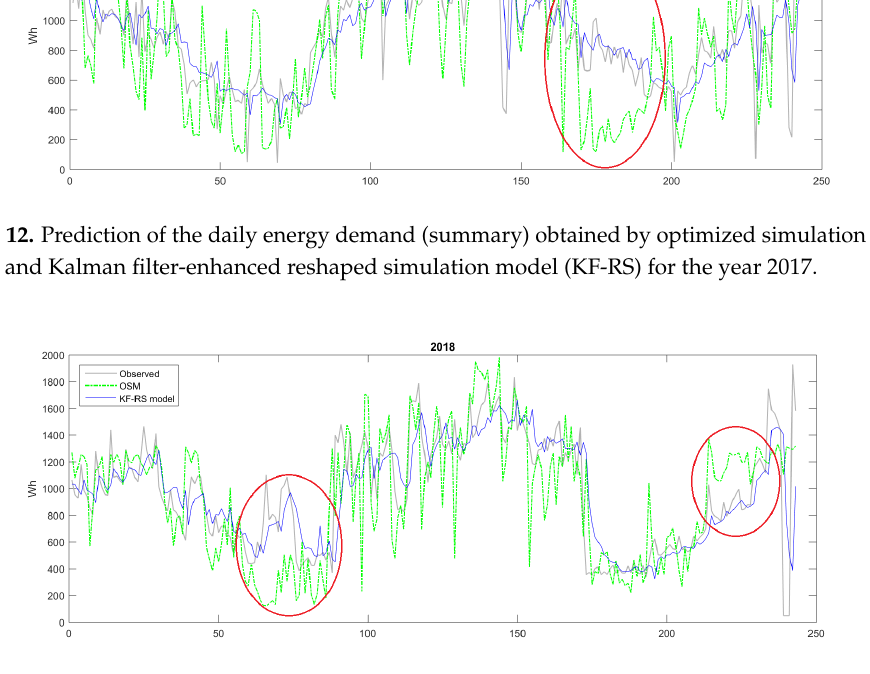
Figure 13. Prediction of the daily energy demand (summary) obtained by optimized simulation model (OSM) and Kalman filter-enhanced reshaped simulation model (KF-RS) for the year